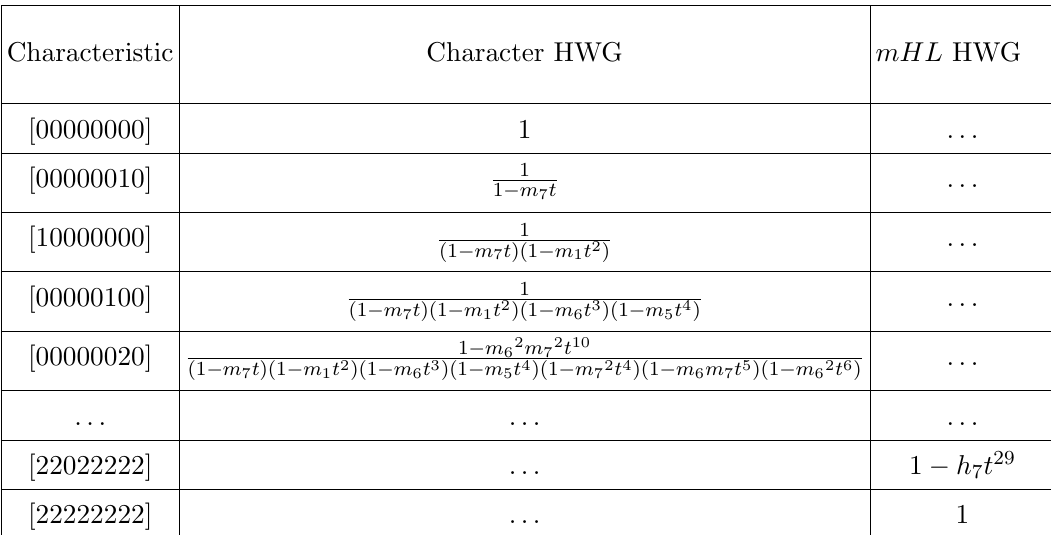
( t ). Orbits in the [00000000]